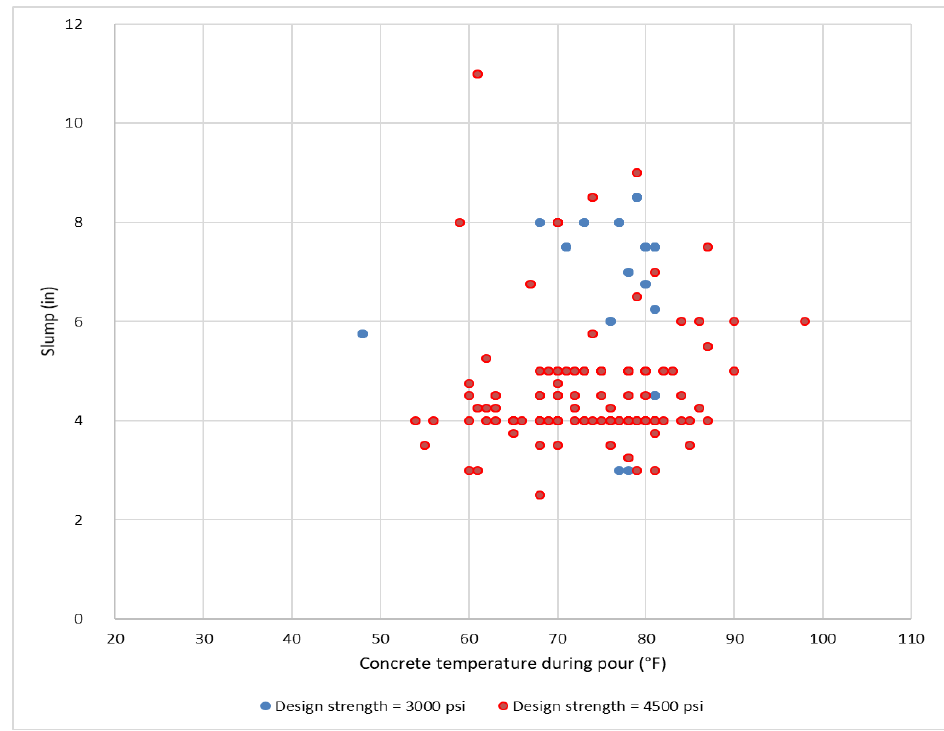
Figure 8. The relationship between slump and concrete temperature.